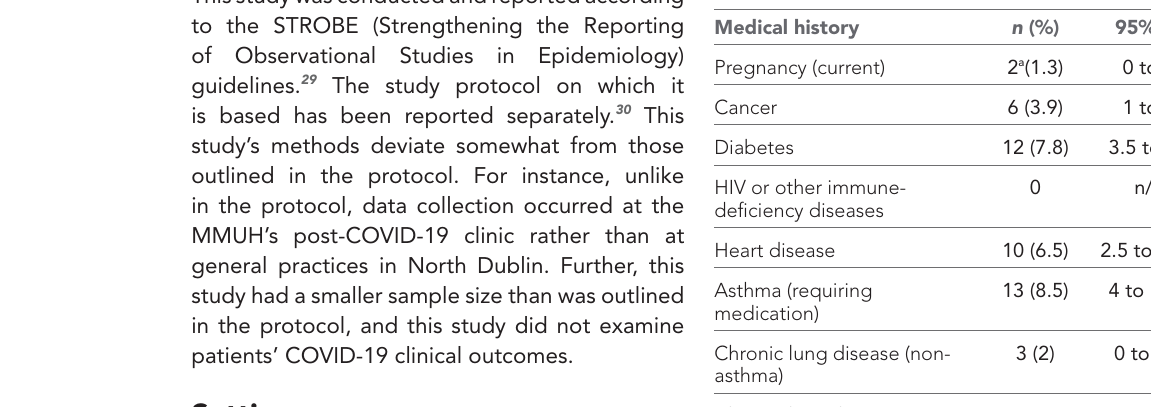
Table 1 Medical history details of patients